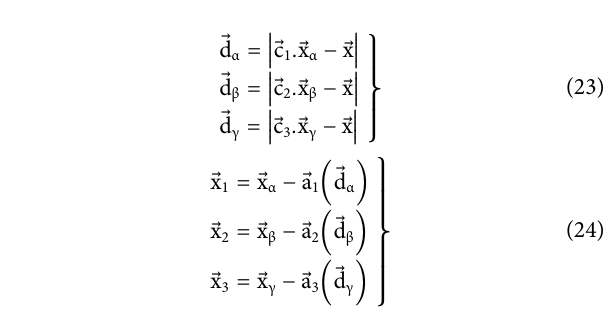
Frontiers in Energy Research |